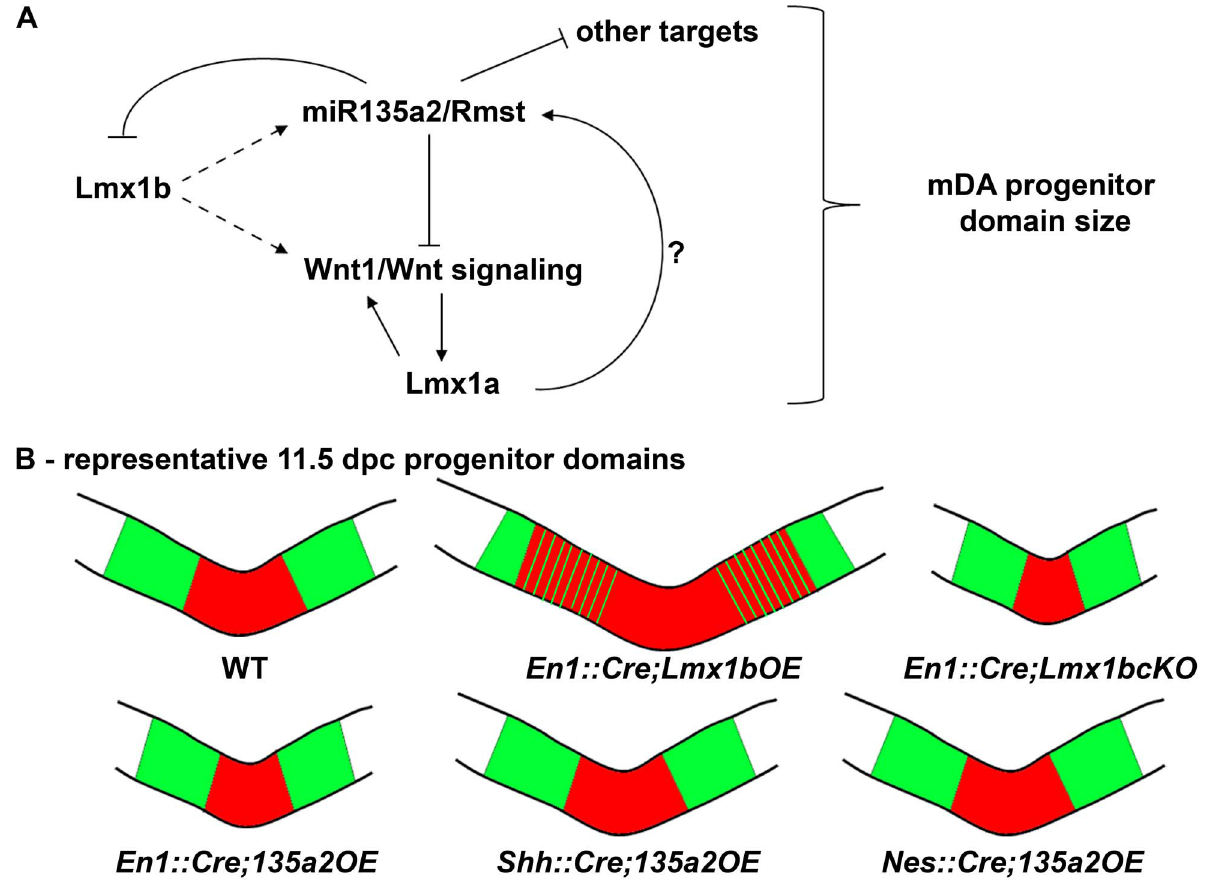
Figure 12. Opposing effects of Lmx1b and miR135a2 on dopamine progenitor allocation. (A) Lmx1b, either directly or indirectly, drives the expression of miR135a2/Rmst , which in turn can negatively modulate the levels of Lmx1b , Wnt1 /Wnt signaling, and other key factors. Together, these factors are critical for net Wnt1 /Wnt signaling, which could influence mDA progenitor patterning and expansion, in part by inducing Lmx1a. Lmx1a also likely has the ability to drive miR135a2/Rmst expression, although this remains to be demonstrated. (B) Cartoon of the midbrain FP region. A balance of Lmx1b and miR135a2 determines mDA progenitor allocation within the FP. Lmx1b maintenance ( En1::Cre;Lmx1bOE ) results in an increased mDA progenitor domain, which encroaches on the Nkx6.1 domain. Conversely, early loss of Lmx1b ( En1::Cre;Lmx1bcKO ) or increasing miR135a2 levels ( En1::Cre;135a2OE ) results in a disproportionately decreased mDA progenitor pool. The outer edges of the mDA progenitor pool are most vulnerable to changes in Lmx1b, and are lost in both these mutants. Later miR135a2 overexpression ( Shh::Cre;135a2OE and Nes::Cre;135a2OE ) results in no change in the DV extent of the mDA progenitor domain. The microRNA, thus acts as a rheostat to set the boundary between the Lmx (red) and Nkx6.1 (green) domains only during an early critical